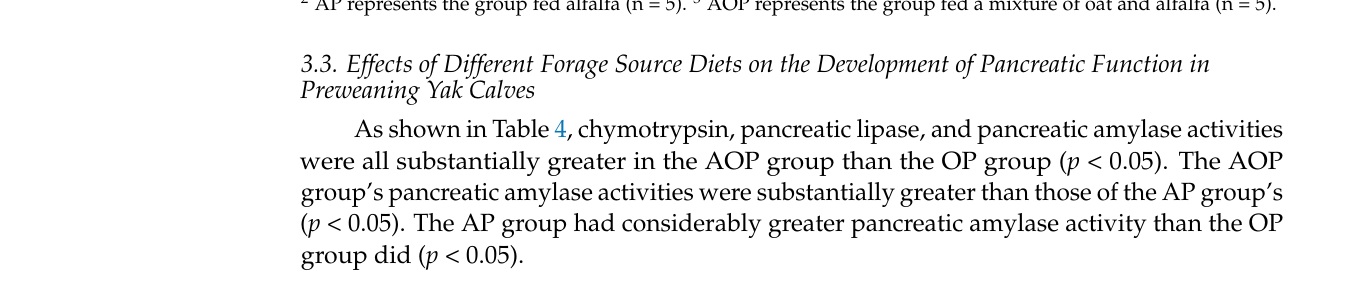
Table 4. Effect of different forage source diets on the activity of pancreatic digestive enzymes in preweaning yak calves (unit: